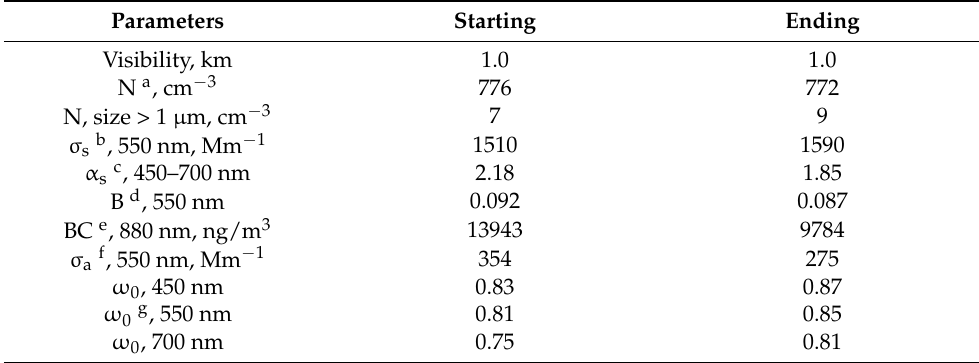
Table 2. Aerosol radiative properties at starting and ending points of